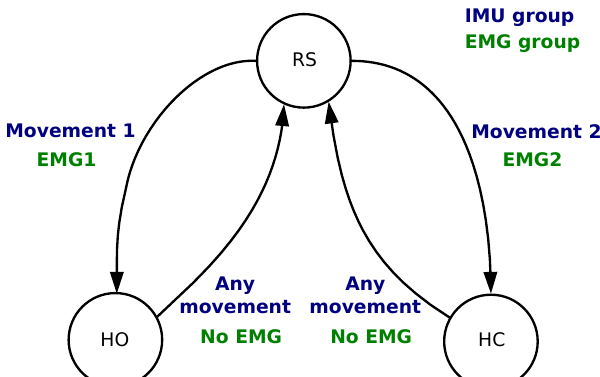
Figure 3. Finite state machine used to map 2 EMG or 2 movements to 3 commands: hand open (HO), hand close (HC) and rest state